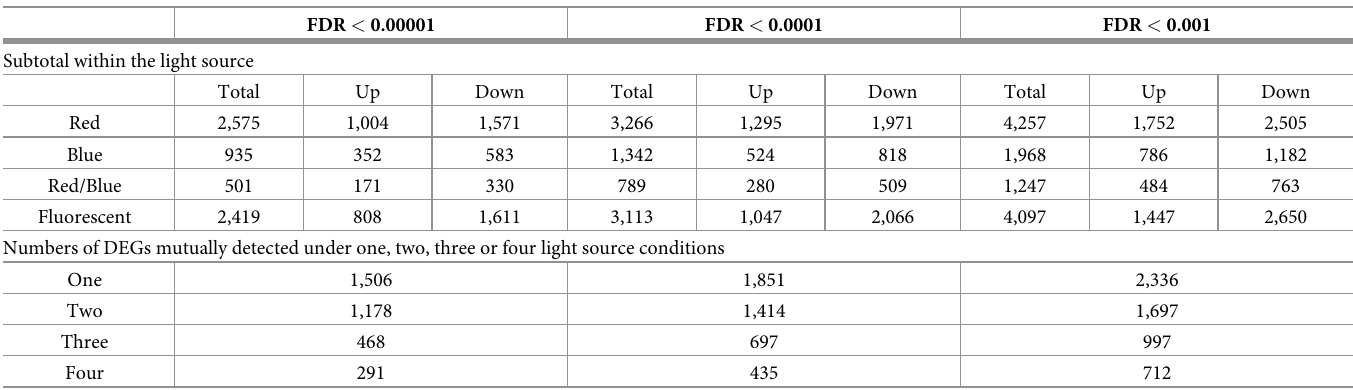
Table 3. Number of differentially expressed genes between the young and the old leaves. FDR < 0.00001 FDR < 0.0001 FDR < 0.001